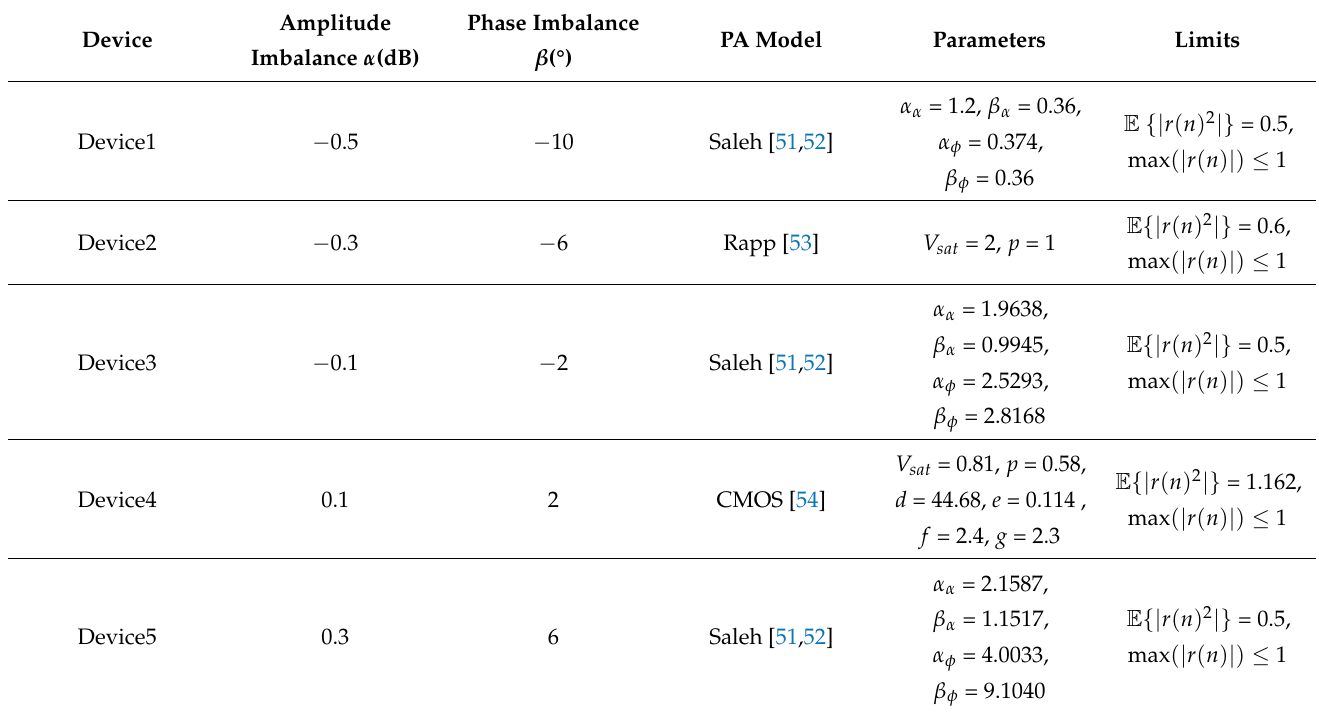
Table 3. Parameter settings for the five different